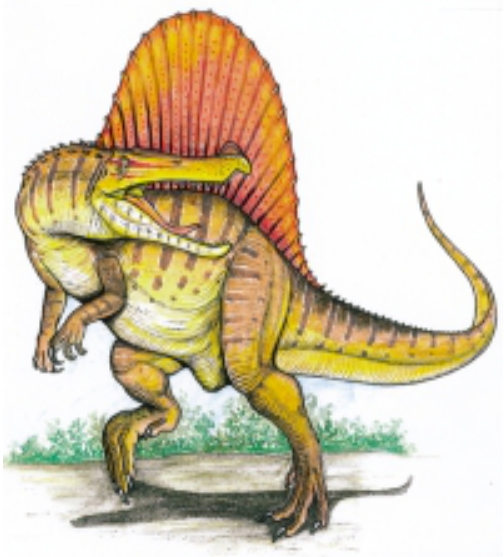
Fig. 15 – Reconstruction of the basal tetanuran Angaturama li- mai (Theropoda) from the Araripe Basin. The sail on the back is hypothetical and was based on Spinosaurus , with whom this taxon is closely related. Note the extension of the snout, giv- ing this dinosaur (like other spinosaurids) a “crocodilian-like” appearance. Fig. 16 – Isolated tooth found in the strata of the Late